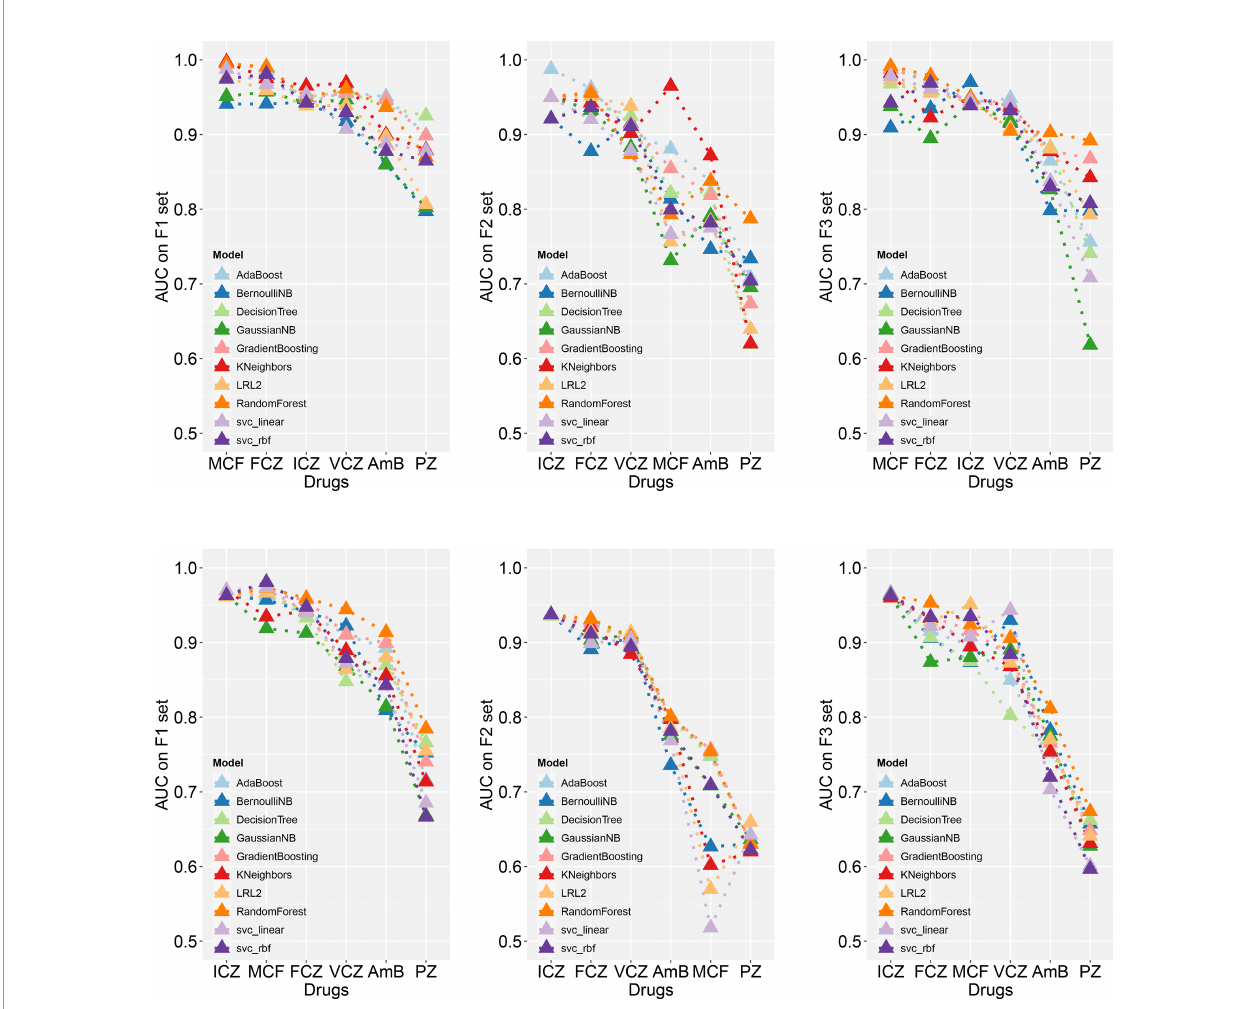
FIGURE 2 | Comparison of the best AUC values using different machine learning classi fi ers.The best models on the balanced (the upper three) and imbalanced (the lower three) test set are shown, respectively. Please see supplementary materials Table S6 for detailed evaluation